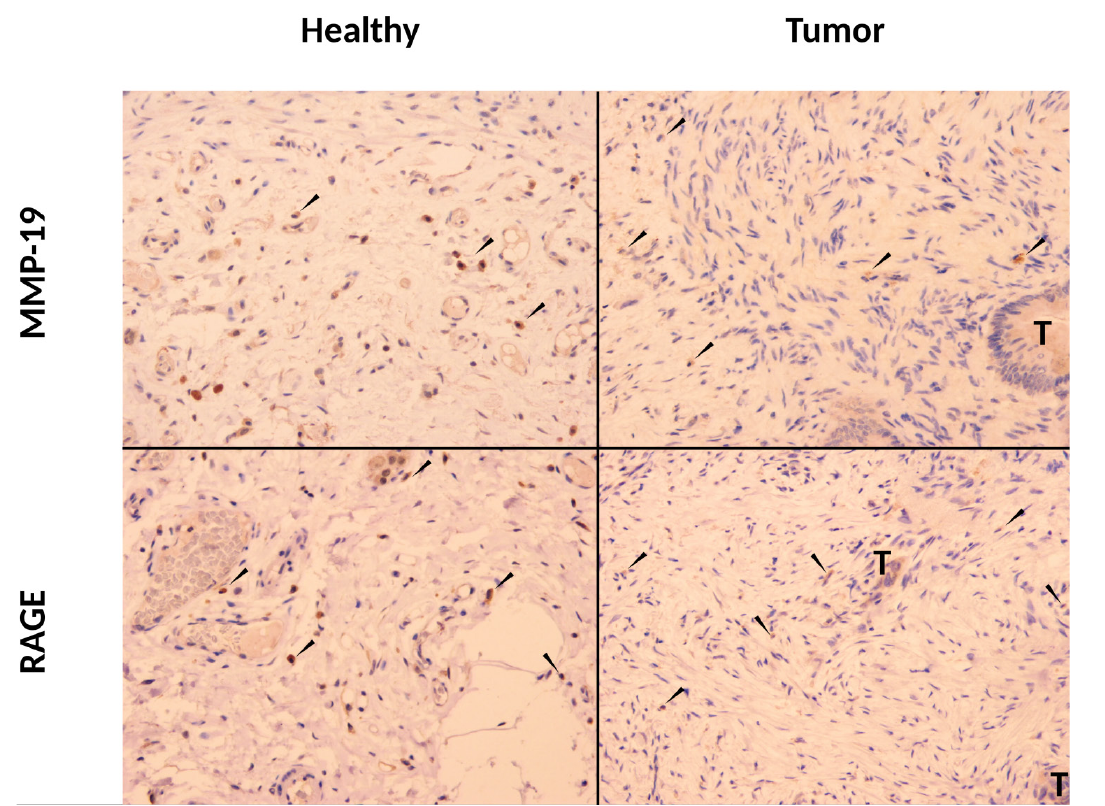
Fig. 2. Microphotographs represent MMP-19 and RAGE expression of macrophages in healthy tissue and tumor. Macrophages (arrowheads) exhibit diffuse strong reaction (2+ to 3+) in healthy tissue compared to overall weak granulate expression in tumor’s proximity.